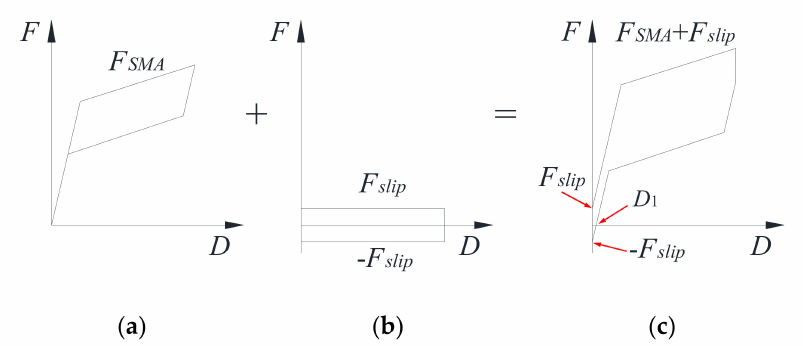
Figure 13. ( a ) SMA, ( b ) slip component, and ( c ) self-centering SMA brace force–displacement curve of self-centering SMA brace.